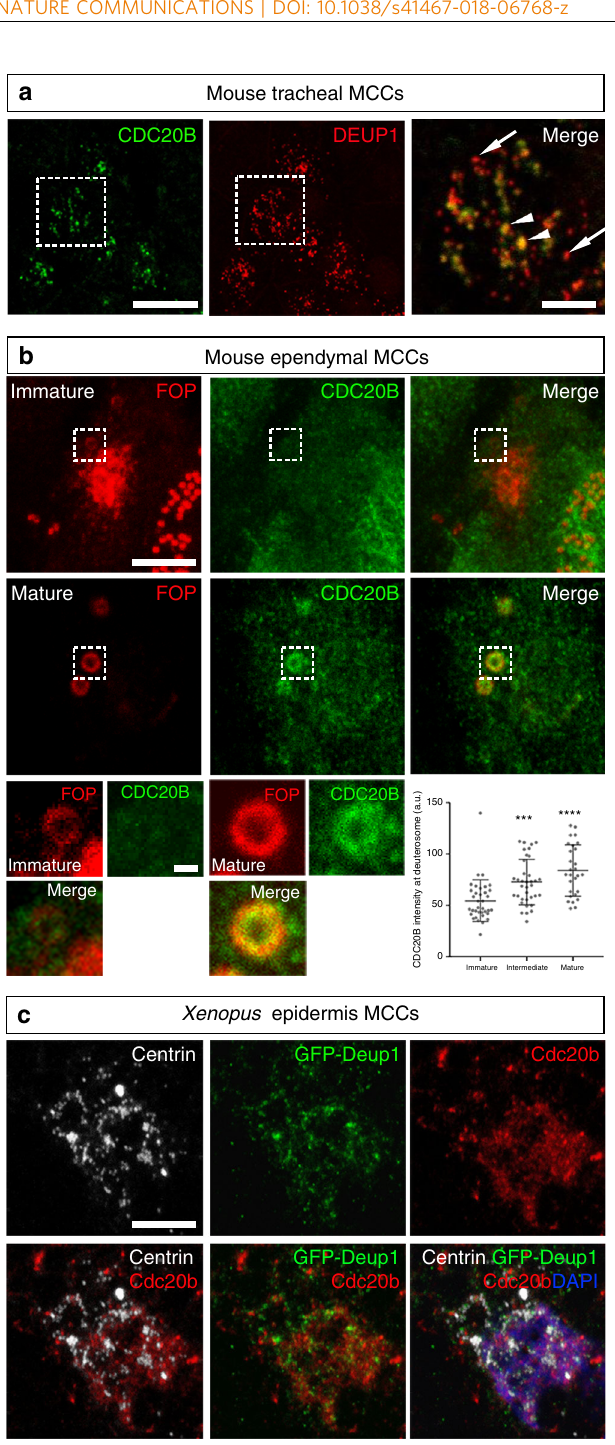
Fig. 3 CDC20B associates to vertebrate deuterosomes. a Double immuno fl uorescence was performed on mouse tracheal MCCs after 3 days of culture in air – liquid interface. Low magni fi cation confocal panels show coincident CDC20B and DEUP1 staining in several individual MCCs. High magni fi cation on a single MCC reveals the prominent association of CDC20B to large deuterosomes marked by DEUP1 (arrowheads). Note that some smaller deuterosomes do not contain CDC20B (arrows). b Mouse ependymal MCCs were immunostained as indicated, and high magni fi cation confocal pictures of cells with immature and mature deuterosomal fi gures were taken. In these cells, centrioles revealed by FOP form a ring around deuterosomes. CDC20B staining forms a ring inside the ring of FOP-positive procentrioles indicating that CDC20B is tightly associated to deuterosomes. Note that the CDC20B signal associated to